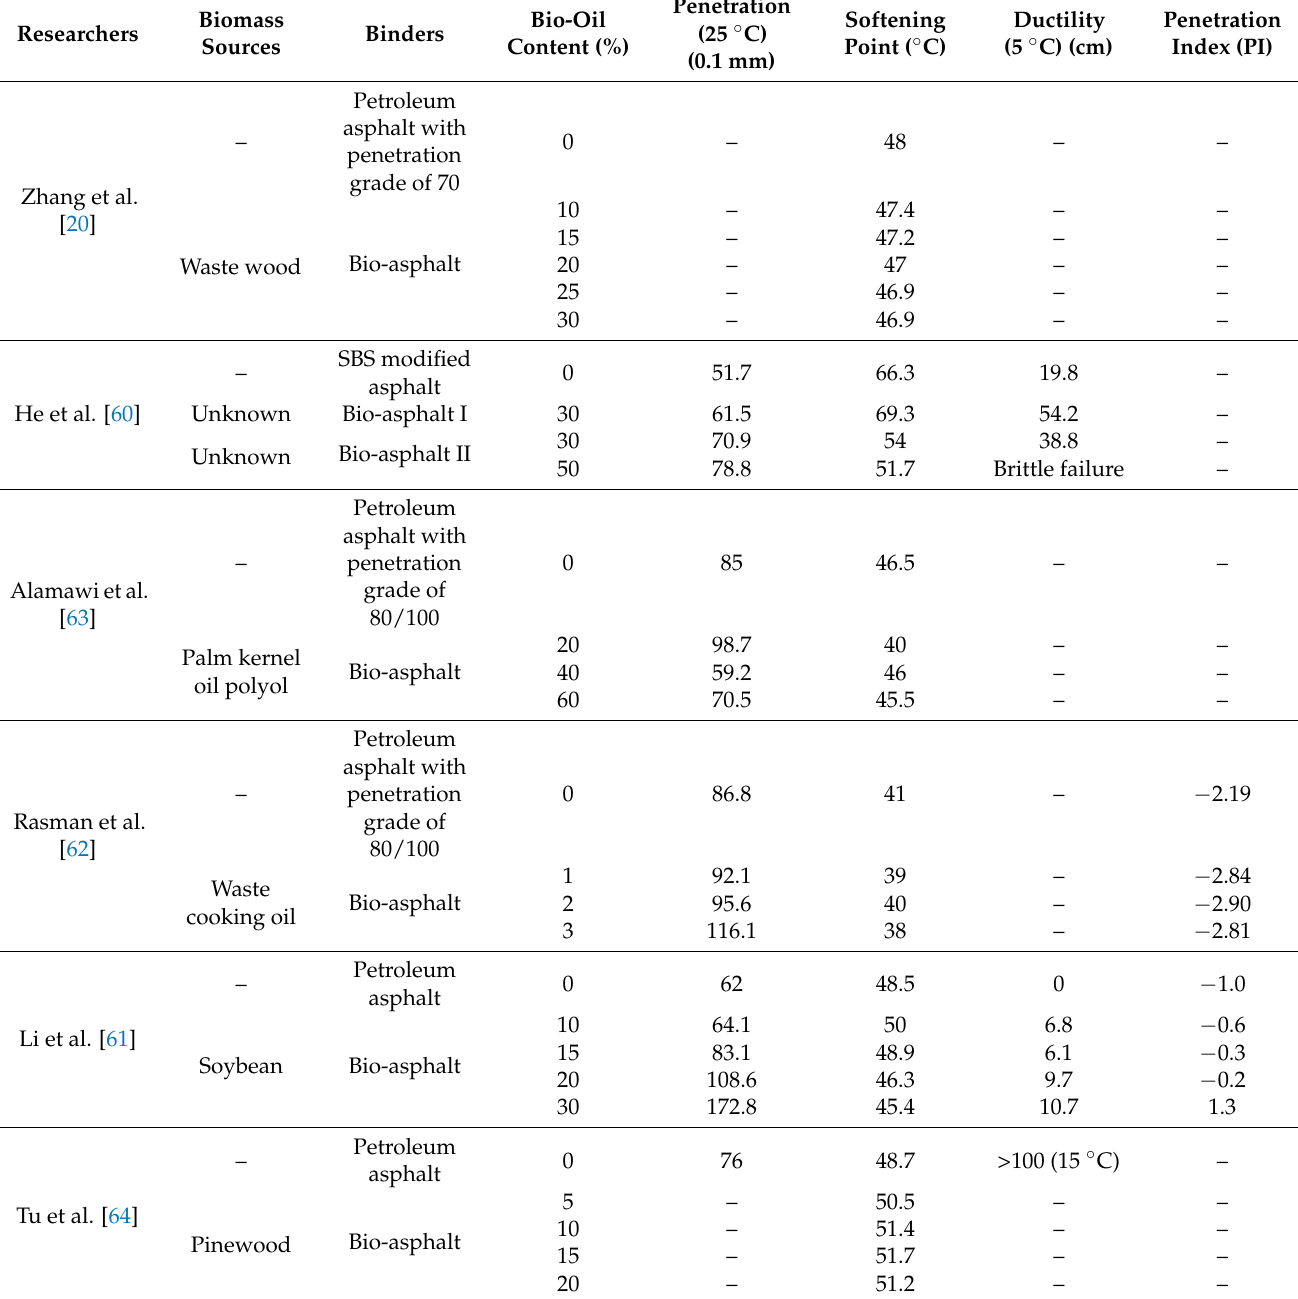
Table 5. Conventional properties of bio-oil modified